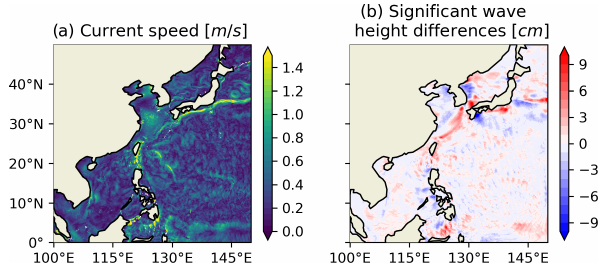
Figure 16. (a) Sea surface current (SSC) snapshot of 8 Octo- ber 2018. (b) The differences in significant wave height between MASNUM wave models with and without SSC